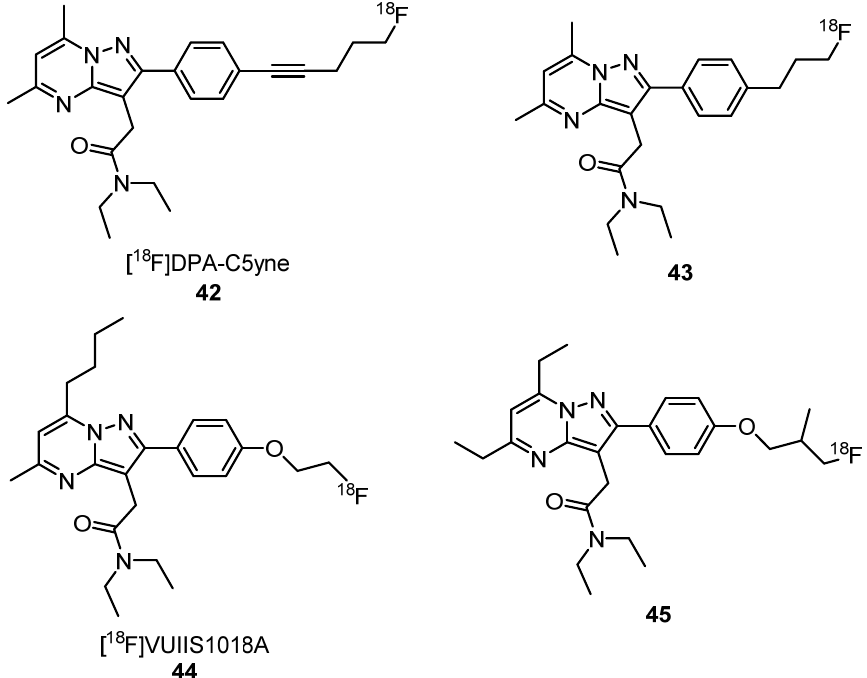
Figure 16. Pyrazolopyrimidine ‐ derived radiotracers 42 – 45 for TSPO PET imaging